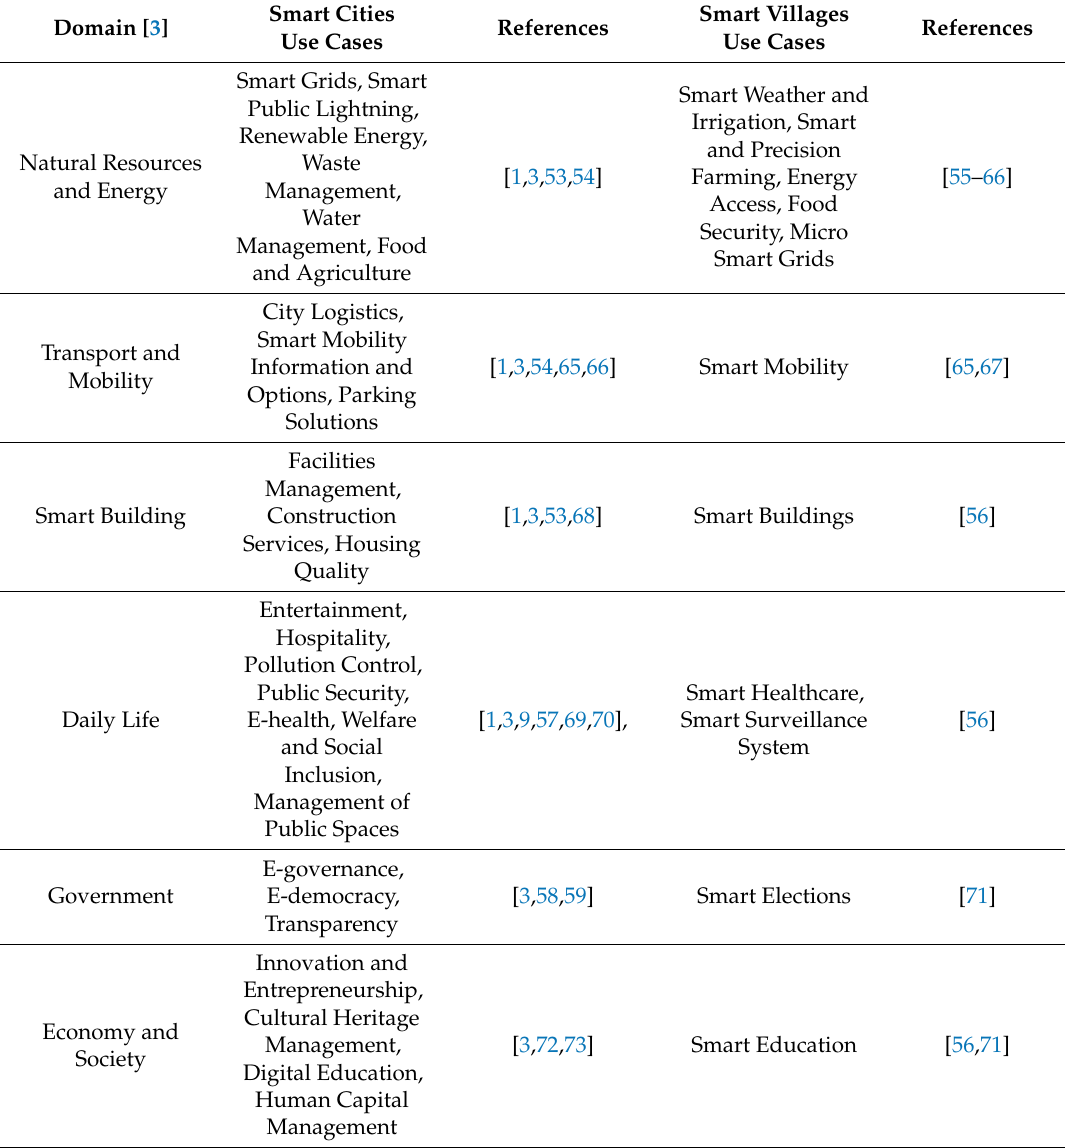
Table 1. A Proposal of a List of IoT Application Domains: Distinct Service Fields with